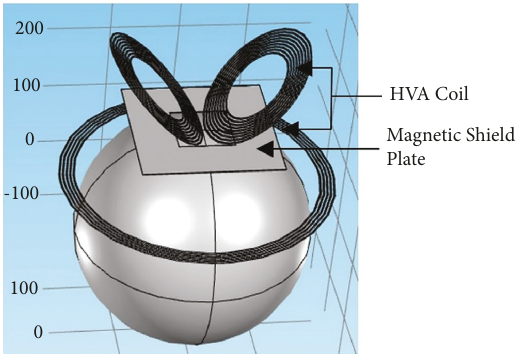
Figure 9: The HVA coil with a magnetic shield plate.